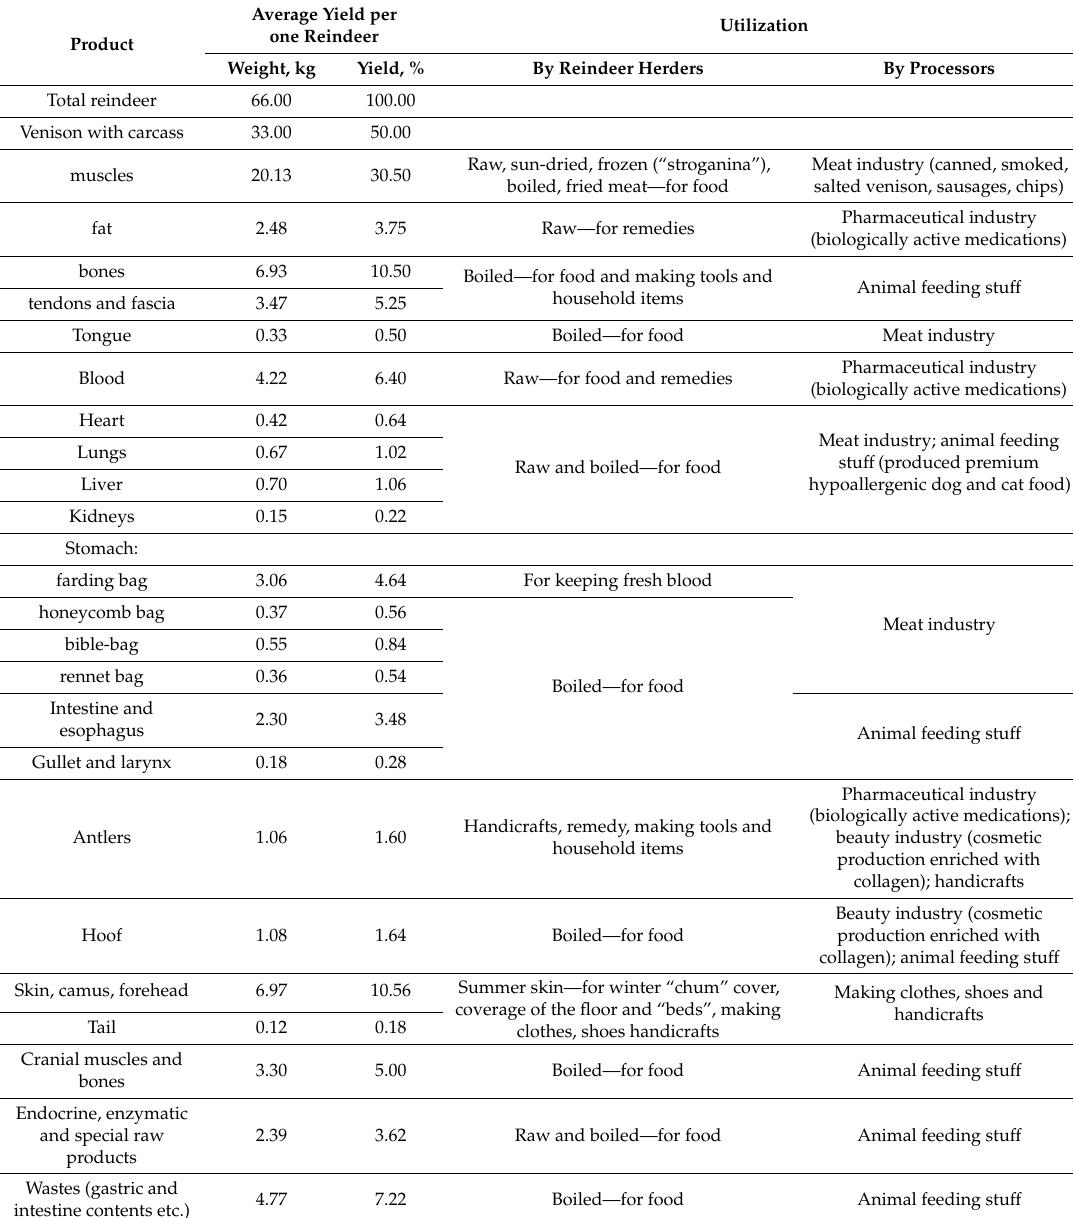
Table 3. The utilization of the reindeer products of